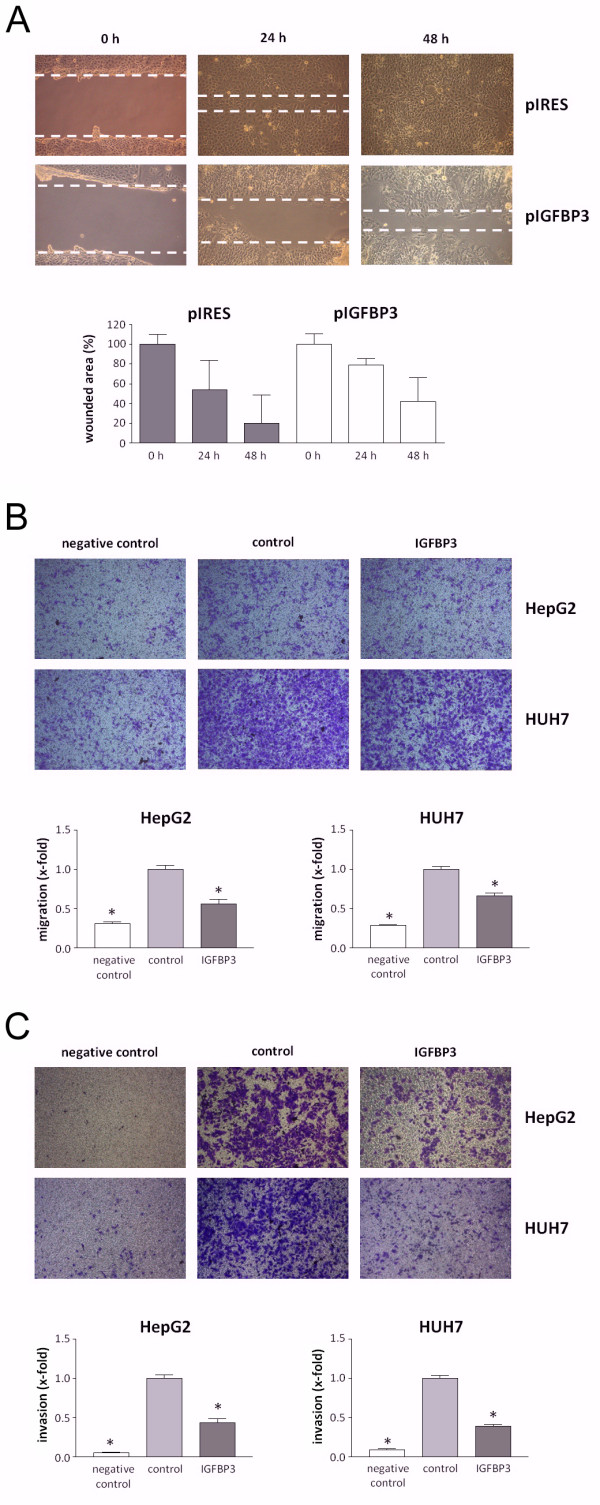
(A) Scratch assay. Representative images of HepT1 cells stably transfected with empty vector control (pIRES) or IGFBP3 migrating into a cell-free wound at 0, 24, and 48 h after wound infliction. Quantitative evaluation of wound closure shows the mean values of three independent experiments. (B) Cell migration and (C) invasion assays. Representative images of HepG2 and HUH7 cells migrating through collagen- (B) or Matrigel-coated (C) transwell plates (pore size, 8 μm) in the presence (IGFBP3) or absence (control) of 1 μg/ml recombinant human IGFBP3. 10% FCS and 50 ng/ml recombinant human HGF served as a chemoattractant in the lower compartment (IGFBP3 and control), whereas a negative control was run without a chemoattractant. The data are the mean ± SEM from three individual experiments. An asterisk indicates P < 0.05.